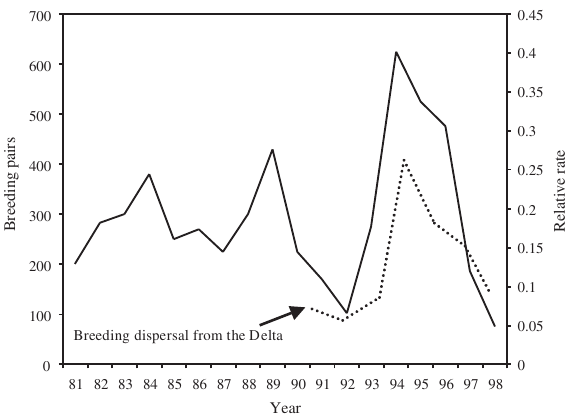
F IG . 3. – Number of Audouin’s gull pairs breeding at the Colum- bretes Islands (solid line) during the last two decades and relative rate of dispersal (dashed line) from the neighbouring colony of the Ebro